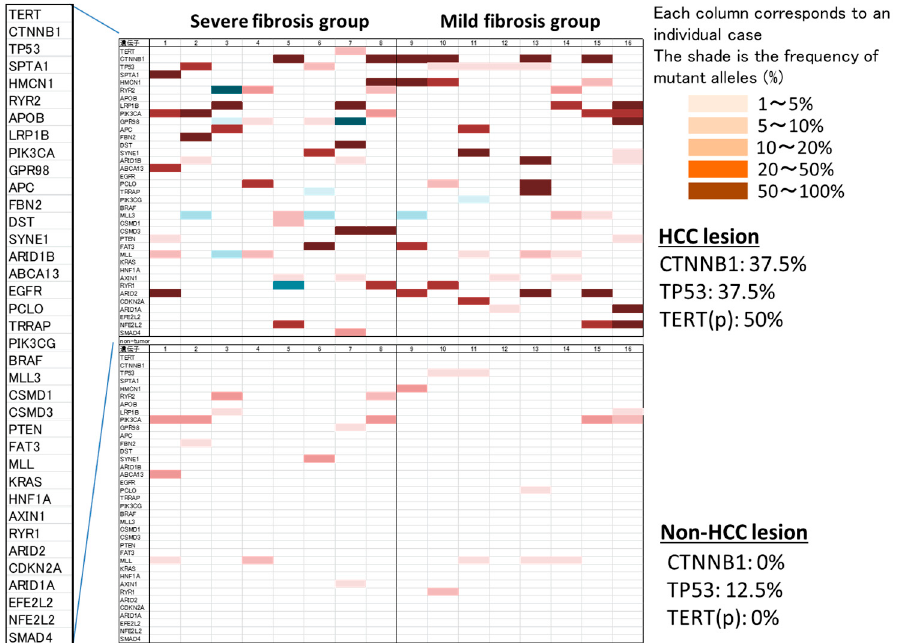
Figure 1. Frequency of somatic mutation detection in cancerous and non-cancerous areas by NSG (heat map). Somatic mutations in the HCC were frequently observed: 37.5% in the CTNNB1 gene, 37.5% in the TP53 gene, and 50% in TERT promoter. On the other hand, although somatic mutations in non-cancerous liver were less frequent, these were observed at a constant frequency regardless of degree of